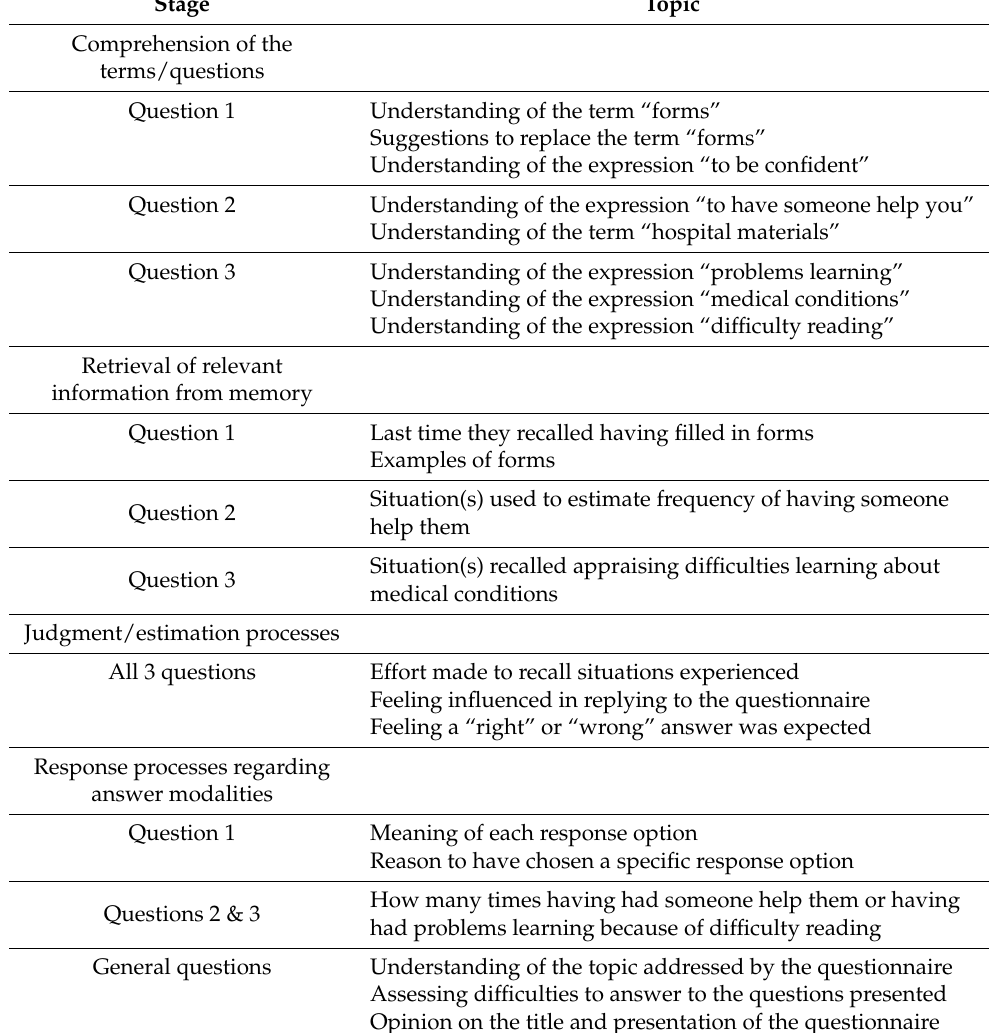
Table 2. Summary of the interview guide for